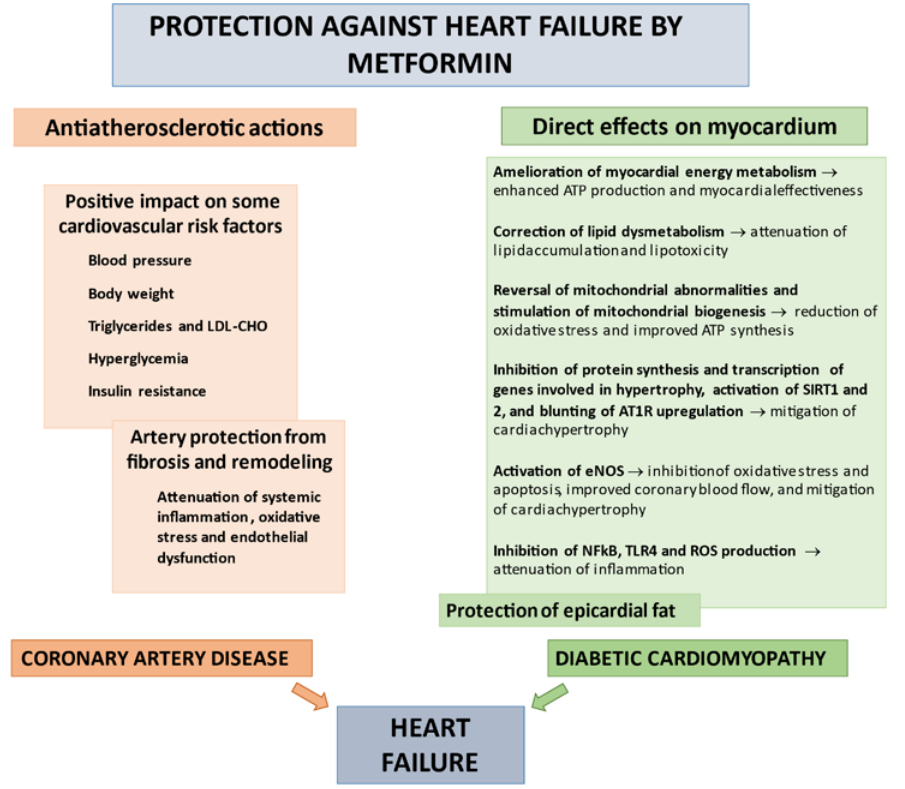
Figure 2. Anti-atherosclerotic actions and direct myocardial protective effects of metformin against HF. AT1R: AngII type HF. AT1R: AngII type 1 receptor; eNOS: endothelial nitric oxide synthase; LDL-CHO: low-density 1 receptor; eNOS: endothelial nitric oxide synthase; LDL-CHO: low-density lipoprotein cholesterol; NF- ĸ B: nuclear factor - lipoprotein cholesterol; NF-kB: nuclear factor-kB; ROS: reactive oxygen species; SIRT1: deacetylase kB; ROS: reactive oxygen species; SIRT1: deacetylase Sirtuin1; TLR4: Toll-like receptor 4. Sirtuin1; TLR4: Toll-like receptor